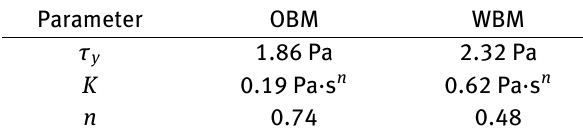
Table 1: Herschel-Bulkley parametrization of the two drilling